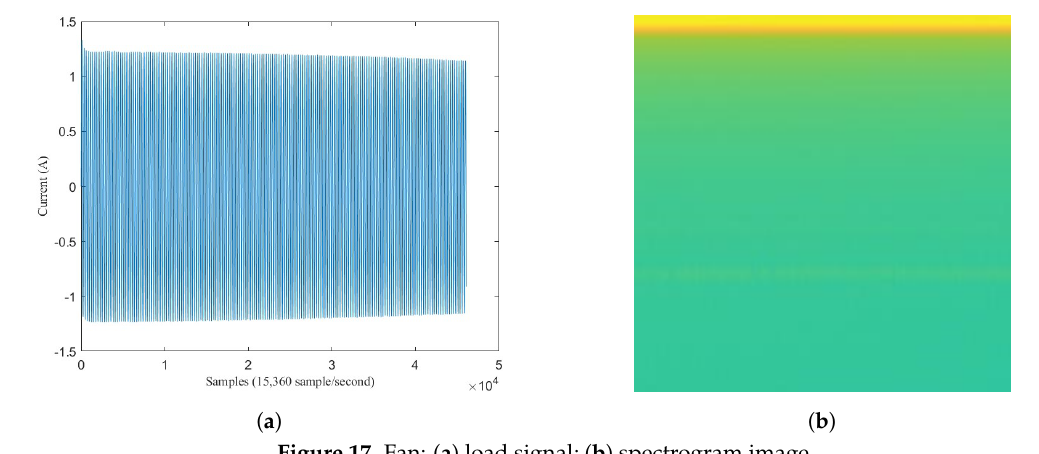
Figure 17. Fan: ( a ) load signal; ( b ) spectrogram